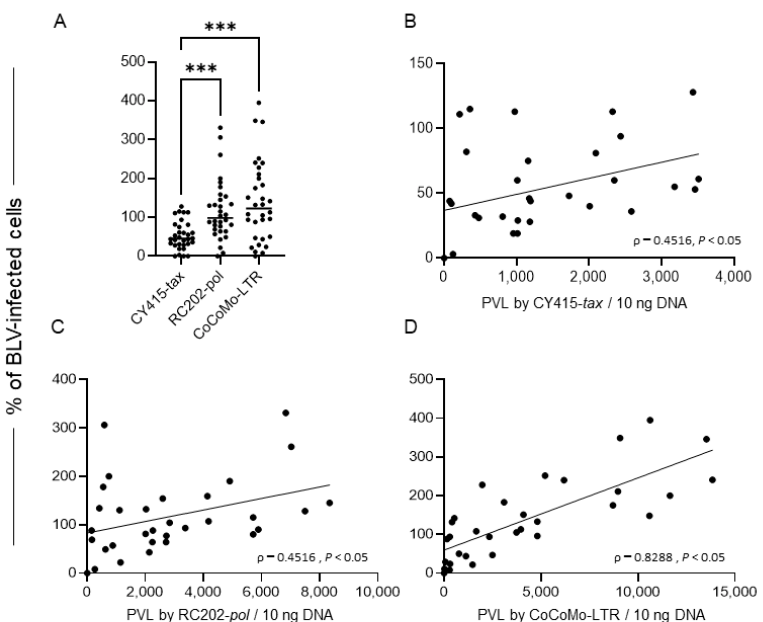
Figure 5. Proportions of bovine leukemia virus (BLV)-infected cells in tumor tissue samples, as determined by different qPCRs. ( A ) Proportion of BLV-infected cells. Differences between values obtained were assessed by using Kruskal–Wallis tests with Bonferroni’s multiple comparison as an ad hoc test. Horizontal bars indicate median values. ***, p < 0.001. ( B – D ) Correlation between proviral load (PVL) and the proportion of BLV-infected cells determined by each qPCR. Spearman’s correlation coefficient ( ρ ) and levels of significance (P) regarding values are indicated in the graphs. Diagonal lines are regression lines.